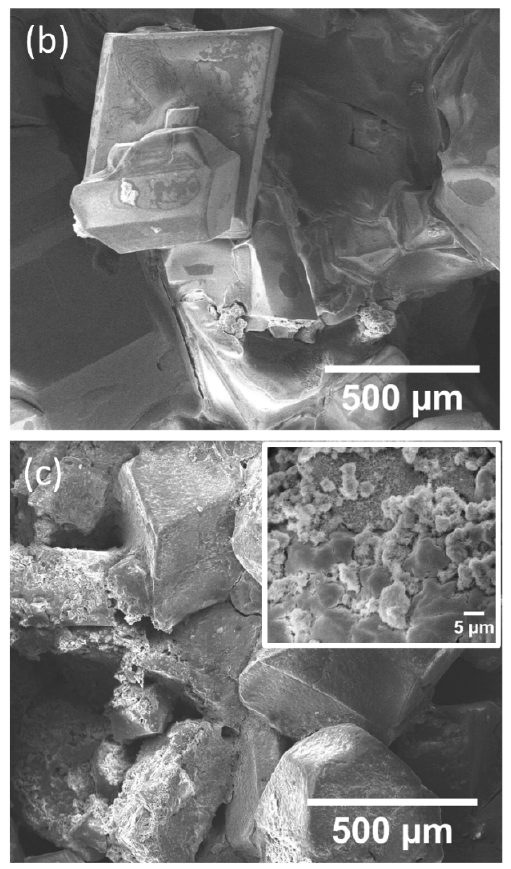
Figure 6. SEM micrographs of the ( a ) CFC reference sample and the ( b ) FFC and ( c ) AFC obtained crystals.